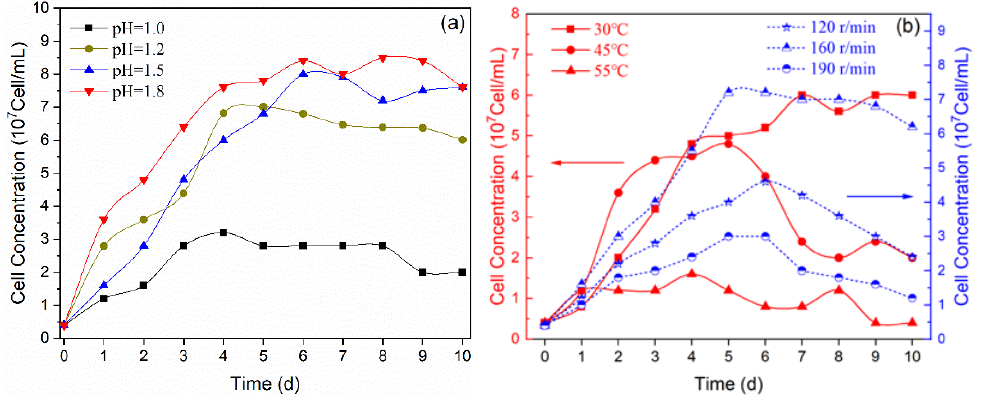
Figure 3. Culture condition results of ( a ) pH, ( b ) temperature, and revolving speed for artificial microbial community.